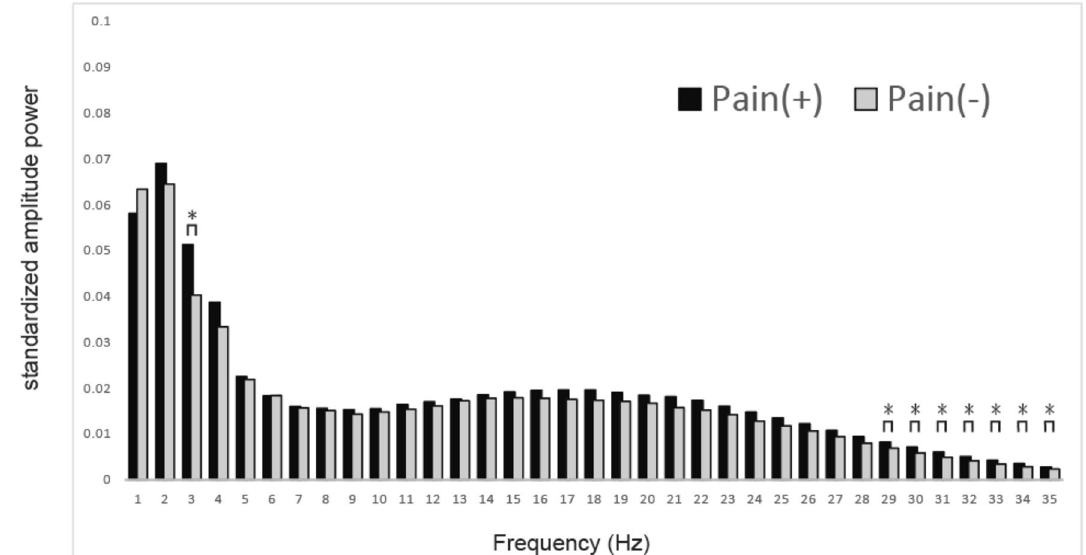
Figure 3. Brain wave amplitude at various frequencies differs significantly between Pain (−) and (+). Brain wave amplitude was recorded during a five-minute walk in patients with (Pain (+), NRS > 1, n = 30) or without (Pain (−), NRS 0, n = 16) hip pain, and the difference in amplitude at frequencies ranging from 1 to 35 Hz was compared between groups. Brain wave amplitude was significantly higher in some frequencies in the Pain (+) than Pain (−) groups (* p < 0.05).